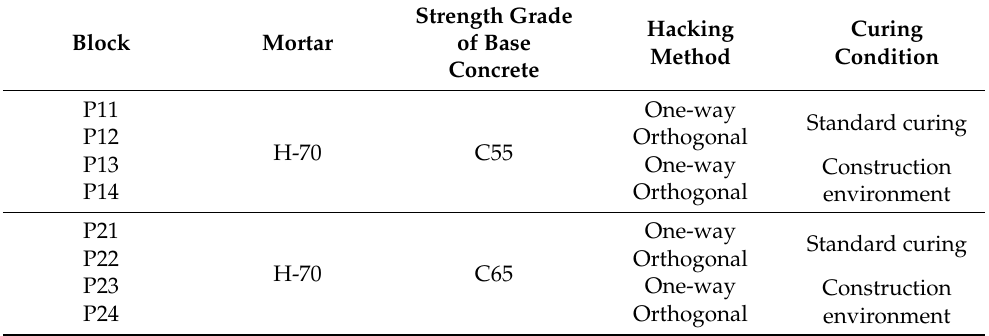
Table 1. The production scheme of test blocks for interface splitting tensile strength.